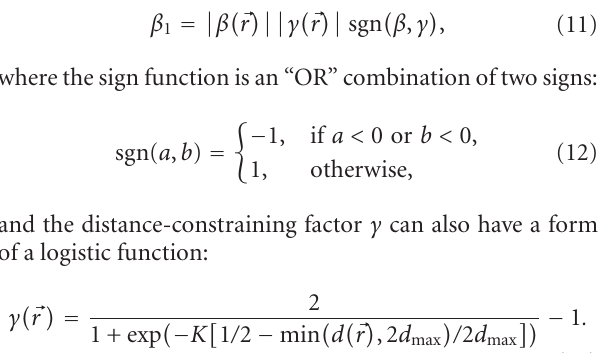
where the subscripts x , y , z denote partial derivatives. The ad- (cid:2) vection velocity vector field V ( (cid:2) r ) is derived from the gradient of the potential ϕ or distance field d